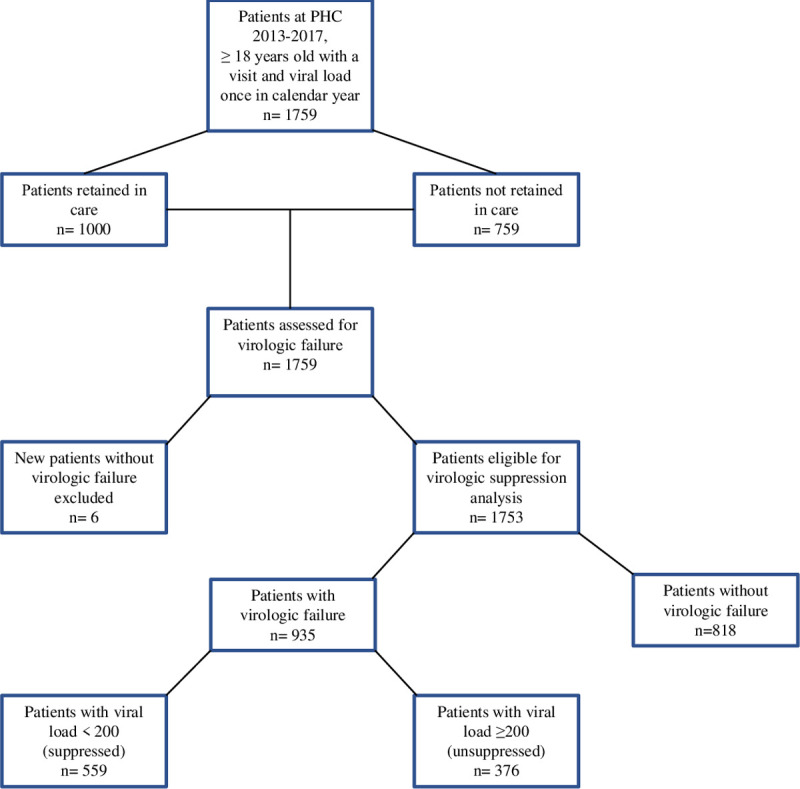
Flowchart of patients assessed for retention in care, virologic failure and viral suppression, Peter Ho Clinic, 2013–2017.